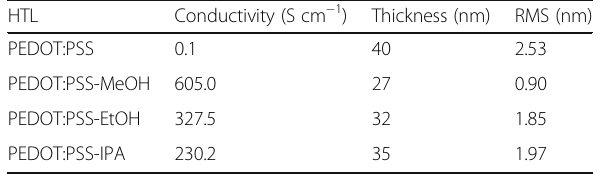
Table 2 Performance of PeLEDs based on treated PEDOT:PSS films HTL